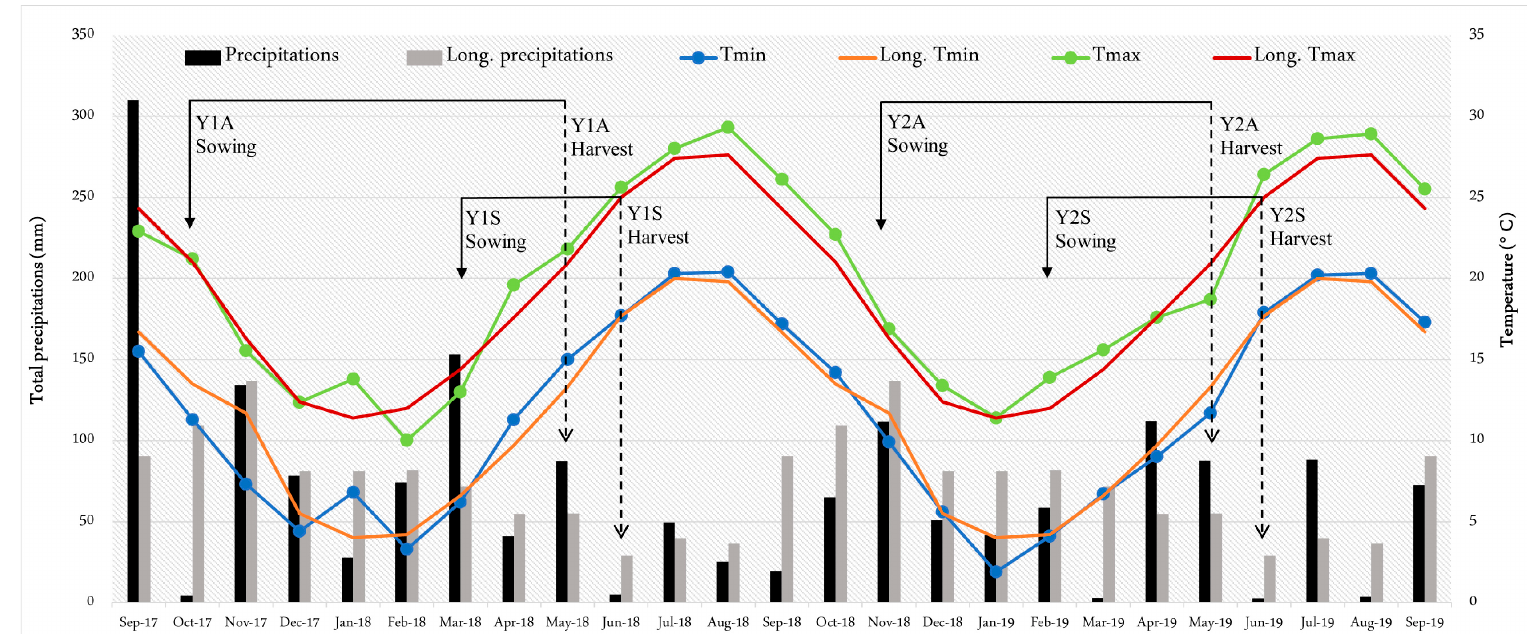
Figure 1. Monthly precipitations and mean minimum and maximum air temperatures ( ◦ C) during the study period, compared to long-term (2001–2019) mean values. Y1A and Y2A for the Autumn-sown crops and Y1S and Y2S for the Spring-sown crops in the 1st and 2nd year of field trial.